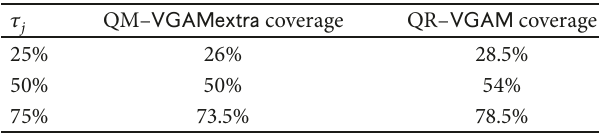
Table 5: Empirical data coverage from quantile–modelling using VGAMextra (QM– VGAMextra ) and quantile–regression from VGAM (QR– VGAM ), after fitting